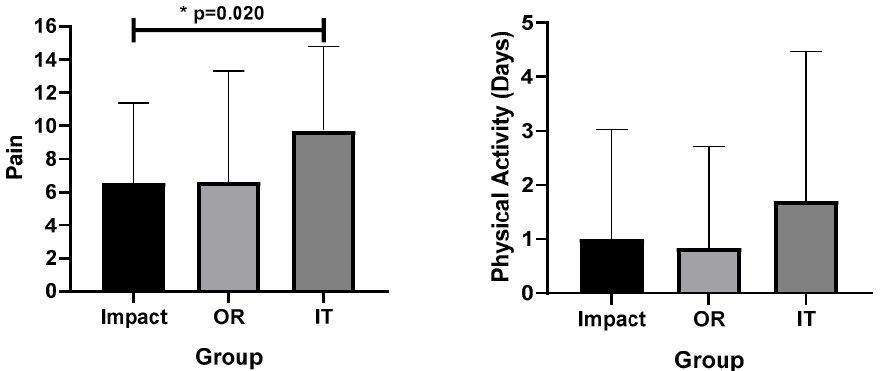
Figure 1. ( A ) Pain and ( B ) physical activity (days) in different pathology etiology types. OR: osteonecrosis + rheumatic, IT: infectious + Legends: OR: osteonecrosis + rheumatic, IT: infectious + traumatic.